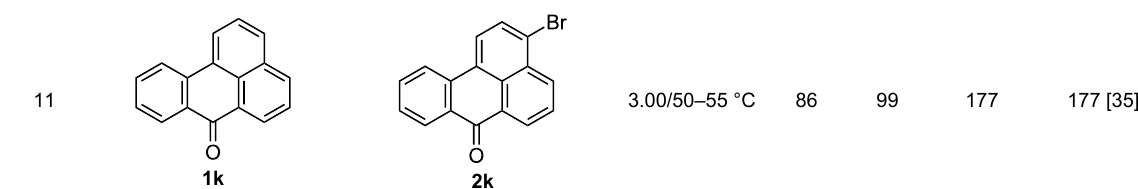
Table 4: Bromination of various aminoanthracene-9,10-dione derivatives and benzanthrone. a (continued)